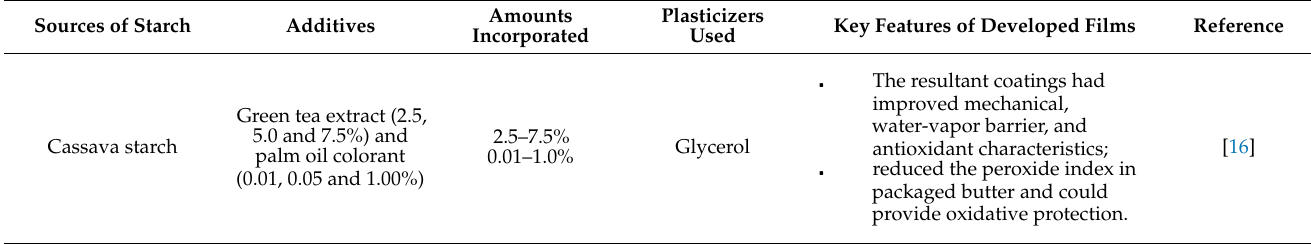
Table 1. Effects of essential oil/extract on starch-based films/coatings. Amounts Plasticizers Sources of Starch Additives Incorporated Used Key Features of Developed Films Reference